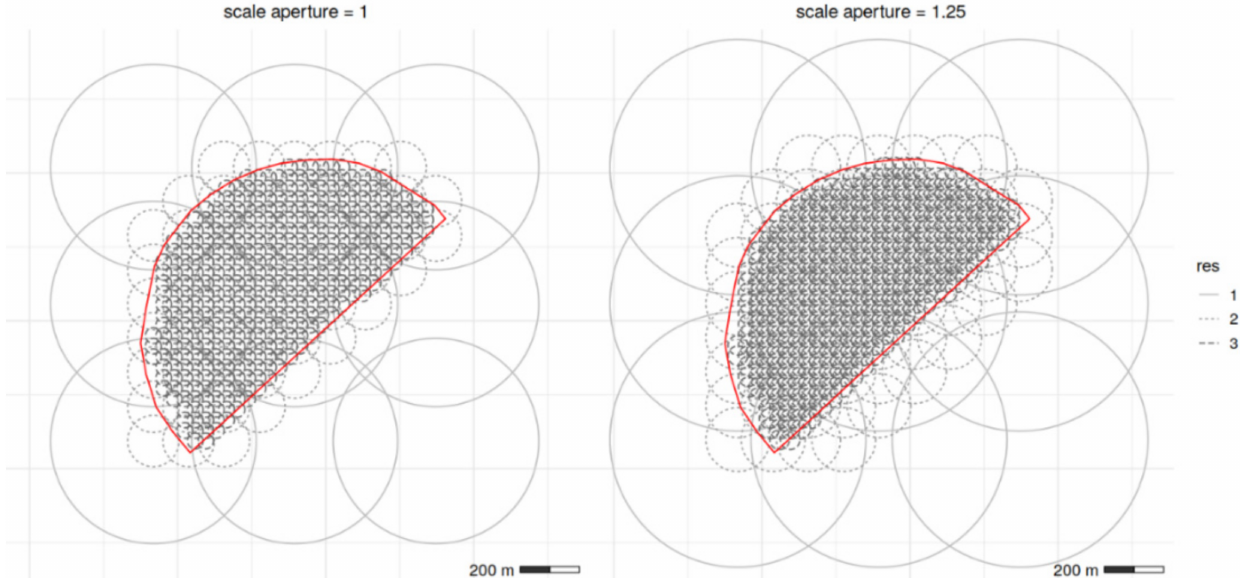
Figure 6. Spatial distribution of bisquare basis functions in study area (red outline), at 3 resolutions for each scale